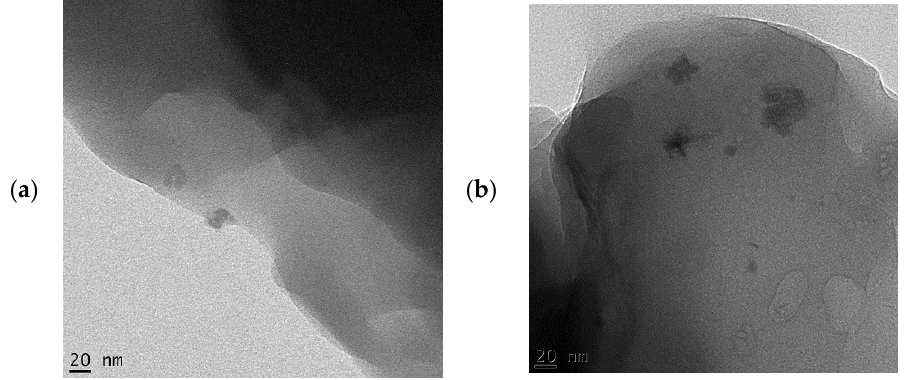
Figure 2. SEM micrograph of lignin–cellulose nanofiber-filled thermoplastic starch composite film.